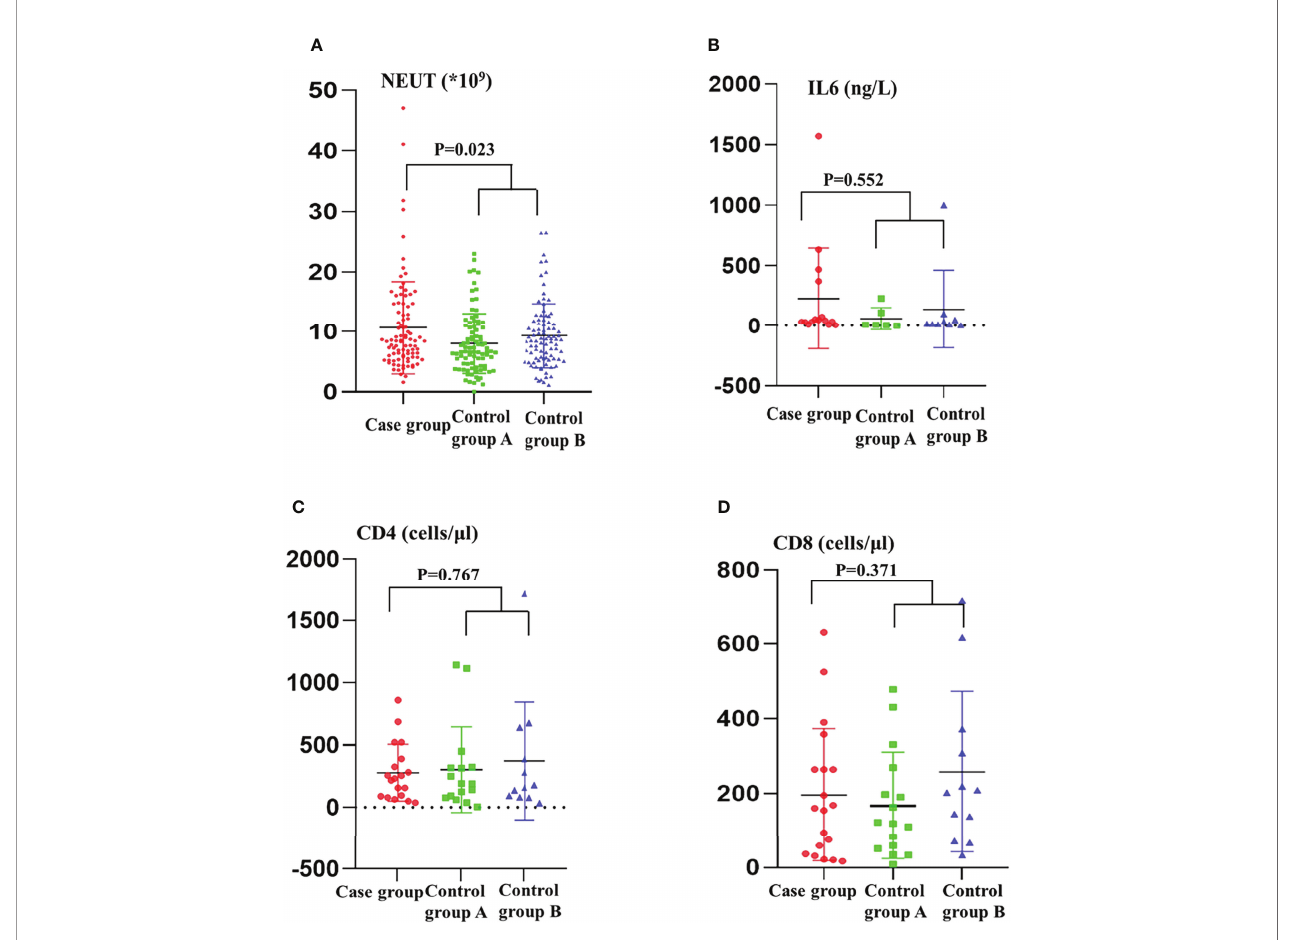
FIGURE 2 | Blood test indexes in the case group and control groups. (A) NEUT; (B) IL6; (C) CD4; (D) CD8; NEUT, neutrophil; IL,